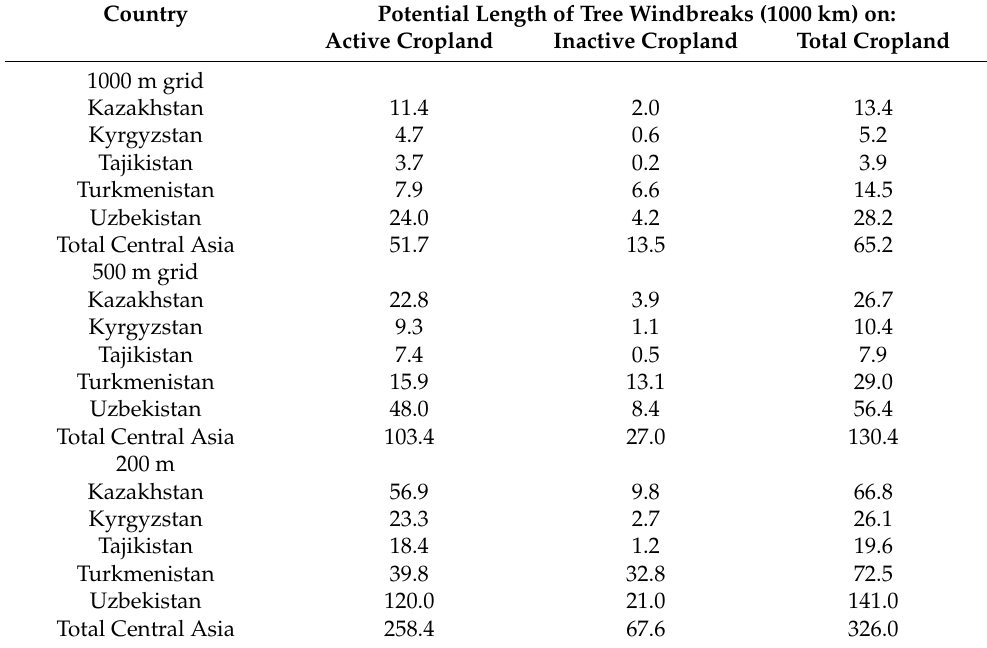
Table 4. Length of tree windbreaks by country under assumption of 1000 m, 500 m, and 200 m grids, current adoption (26% of the potential tree windbreaks realized). Country Potential Length of Tree Windbreaks (1000 km) on: